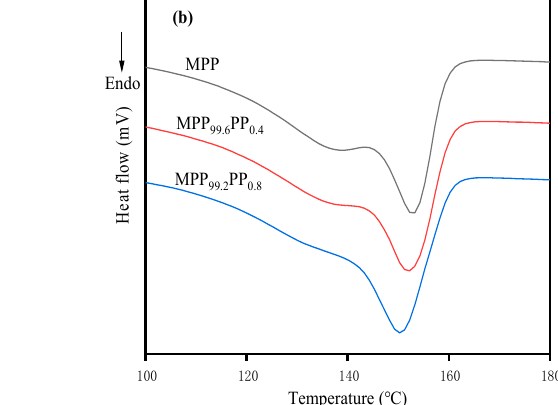
Table 3. Data on melting and crystallization. Figure 7. Differential scanning calorimetry for MPP and MPP/ATT nanocomposites: ( a ) first cooling curves; ( b ) second heating curves.